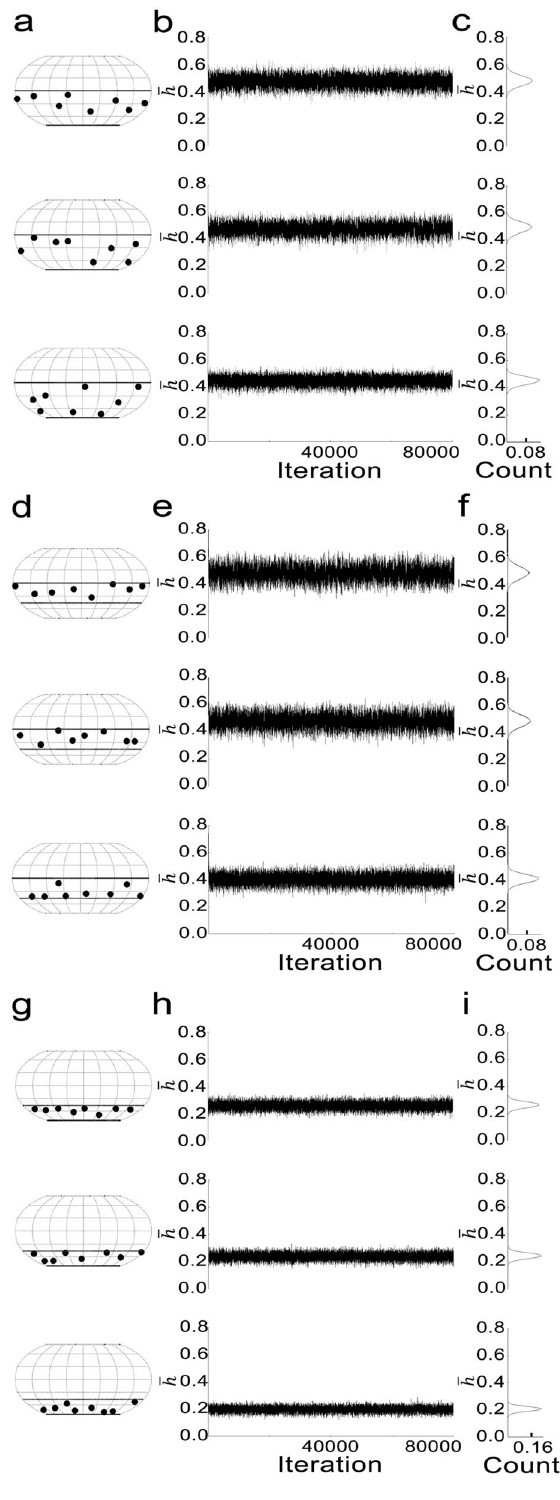
Figure 3. Example distributions of the AZM connection sites on the hemispherical surfaces of nine different SVs, variations in their average heights from the PM, and histograms of the average heights from Markov Chain Monte Carlo simulations. ( a,d,g ) Three different sets of eight AZM connection sites randomly distributed on the surface of an SV’s hemisphere, upper half hemisphere, and lower half hemisphere, respectively plotted on Robinson maps to visualize their locations on their entire vesicle surface. The hemispheres of the vesicles facing the PM lie below the equator drawn in bold dotted lines. ( b,e,h ) Fluctuations in the average height ( h ) of each set of the AZM connection sites generated over 80000 iterations using Markov Chain Monte Carlo simulations. ( c,f,i ) Histograms of the average heights for the three different sets of the AZM connection sites from the